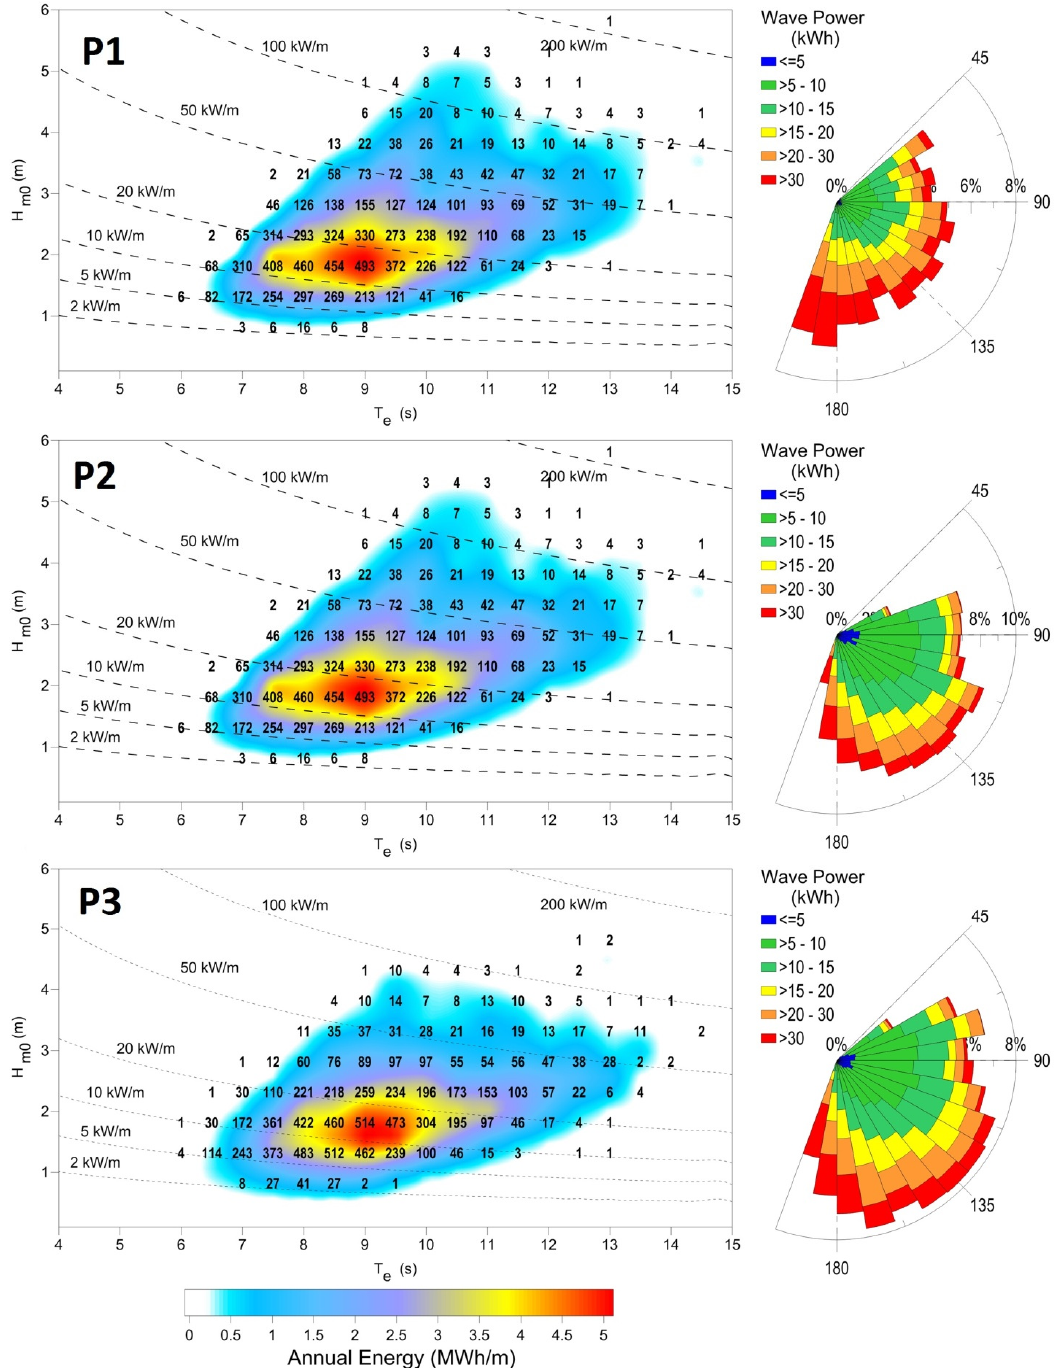
Figure 3. Characterization of the yearly average wave energy points P1, P2 and P3, in terms of significant wave height (H m0 ) and energy period (T e ). The color scale represents annual energy per meter of wave front (in MWh/m). The numbers within the graphs indicate the occurrence of sea states (in number of hours per year) and the isolines refer to wave power.